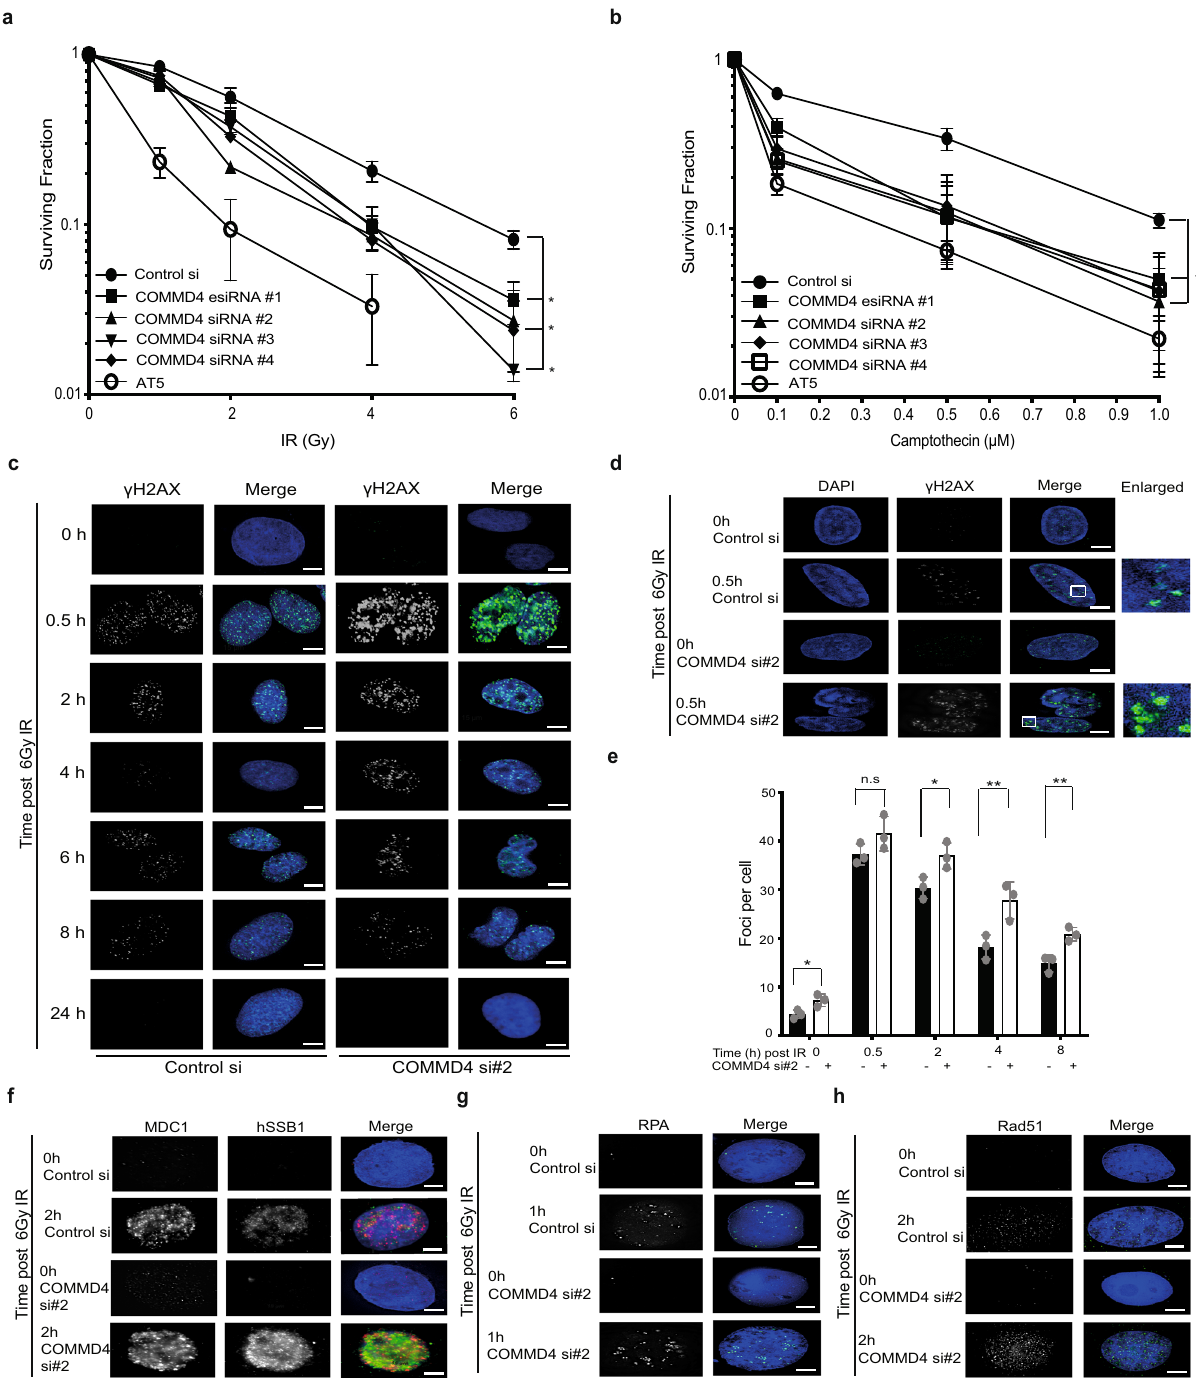
Fig. 1 Loss of COMMD4 results in genomic instability. a , b U20S cells were transfected with COMMD4 esiRNA (#1) and/or siRNA #2, siRNA #3 and siRNA #4 to deplete COMMD4 protein levels and treated with varying doses of IR or CPT. A clonogenic assay was subsequently carried out to determine the sensitivity of COMMD4-depleted cells to these agents. AT5; cells from an A-T patient. Asterix (*) denotes p < 0.05. Error bars represent mean ± SD from three independent experiments. c Immuno fl uorescence on control and COMMD4-depleted U2OS cells treated with 6 Gy of IR followed by recovery at the time points shown and stained with γ H2AX. d γ H2AX foci in control and COMMD4-depleted cells using the OMX super-resolution microscope. e Plot of γ H2AX foci numbers for c and d . f Immuno fl uorescence experiment demonstrating MDC1 and hSSB1 foci formation in control and COMMD4-depleted cells before and 2 h after irradiation. g , h Immuno fl uorescence experiment demonstrating RPA and Rad51 foci formation respectively in control and COMMD4-depleted cells before and after irradiation. DAPI shows the nucleus. ns not signi fi cant where p > 0.05, * p < 0.05 and ** p < 0.005. Error bars represent mean ± SD from three independent experiments where 50 cells were quanti fi ed per condition. Scale bar denotes 5 μ